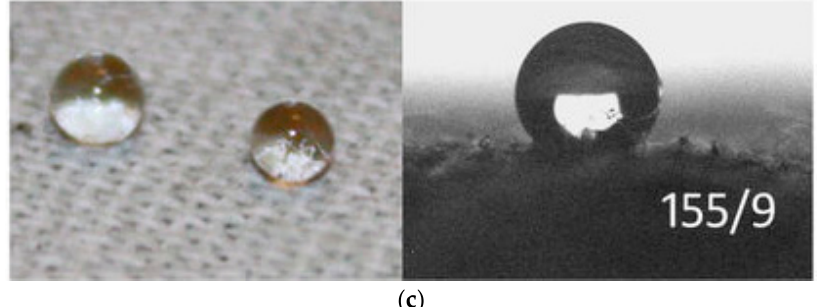
Figure 5. SEM and SPM micrographs of fabricated surfaces. Fabricated by: ( a , b ) untreated ( left ), silica Figure 5. ( a , b ) SEM and SPM micrographs of fabricated surfaces: untreated ( left ), silica sol ( middle ) sol ( middle ) and Cu-doped silica ( right ); and ( c ) Water drops on surface fabricated by 0.5% Cu-doped and Cu-doped silica ( right ); ( c ) Water drops on surface fabricated by 0.5% Cu-doped silica sol and its silica sol and its contact angle value. Reproduced from [47] with permission; Copyright Springer 2011. contact angle value. Reproduced from [47] with permission; Copyright Springer